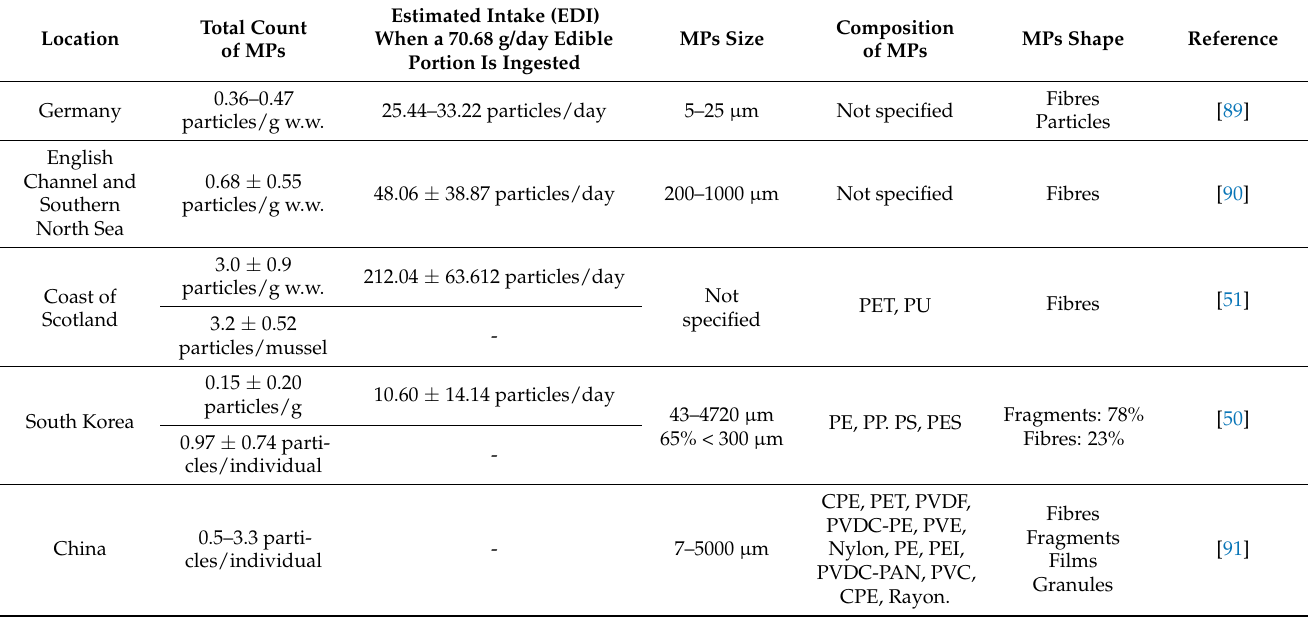
Table 2. MPs contents in bivalve molluscs and crustaceans and dietary intake estimation in a 70.68 g/day consumption